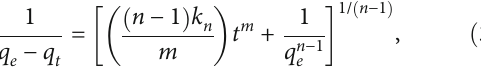
Scheme 1: Schematic diagram of the experimental setup of the SBCR (1) N controller, (5) gas mixer, (6) slurry bubble column, (7) temperature controller, (8) pH probe, (9) thermocouple, (10) condenser, (11) CO analyzer, and (12)